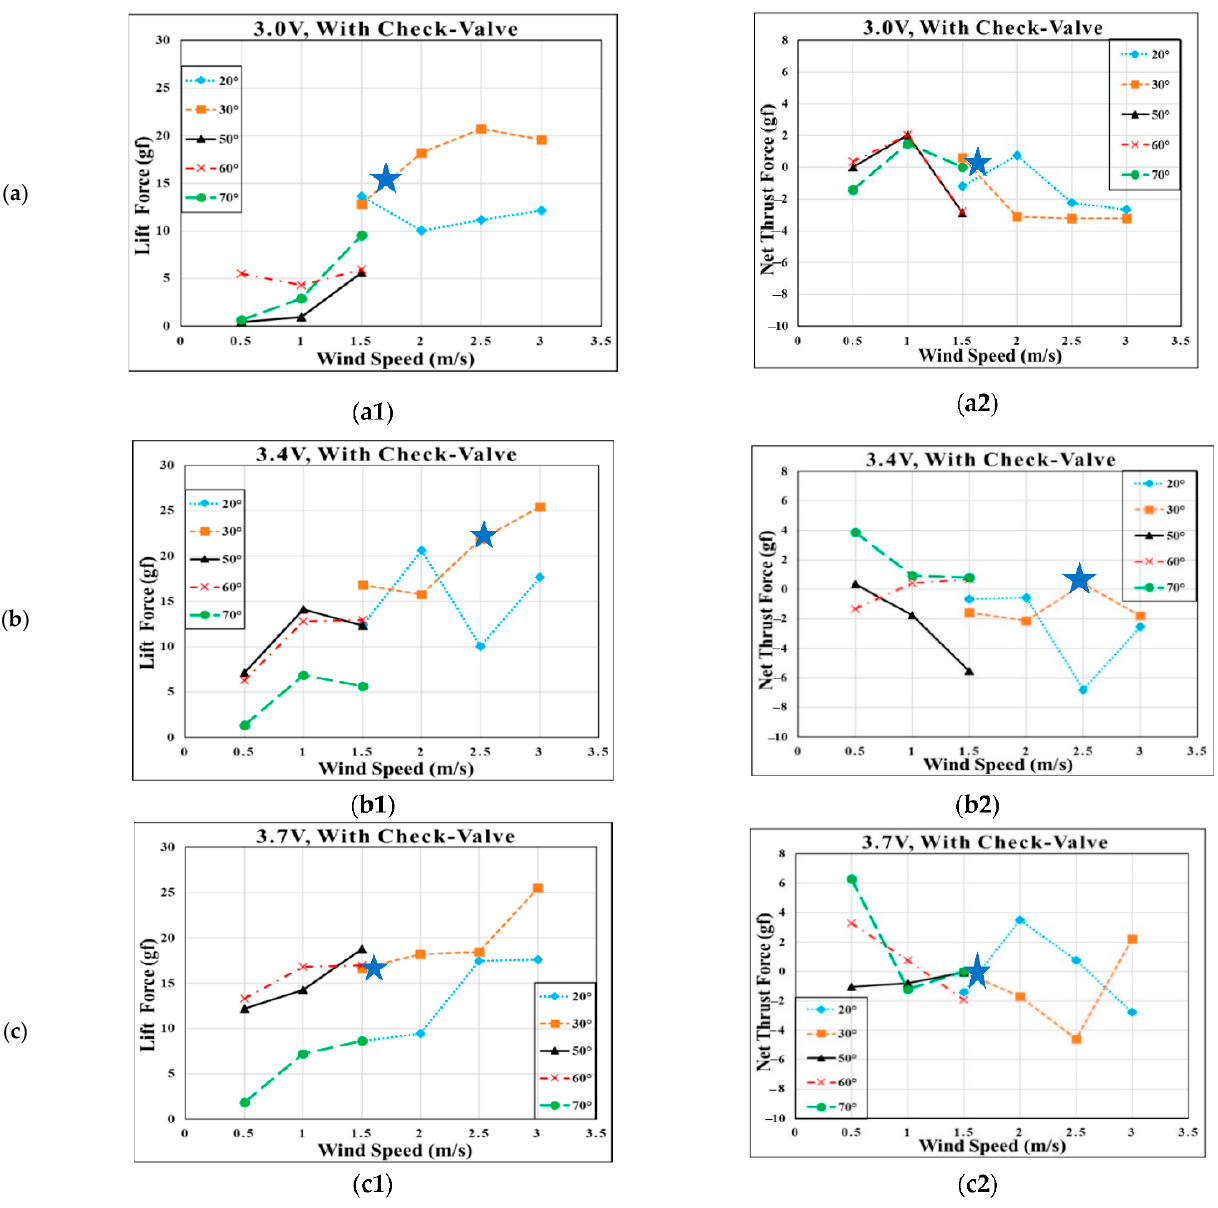
Figure 9. The lift and net thrust subjected to the wing with check-valves for various driving voltages: ( a ) 3.0 V; ( b ) 3.4 9